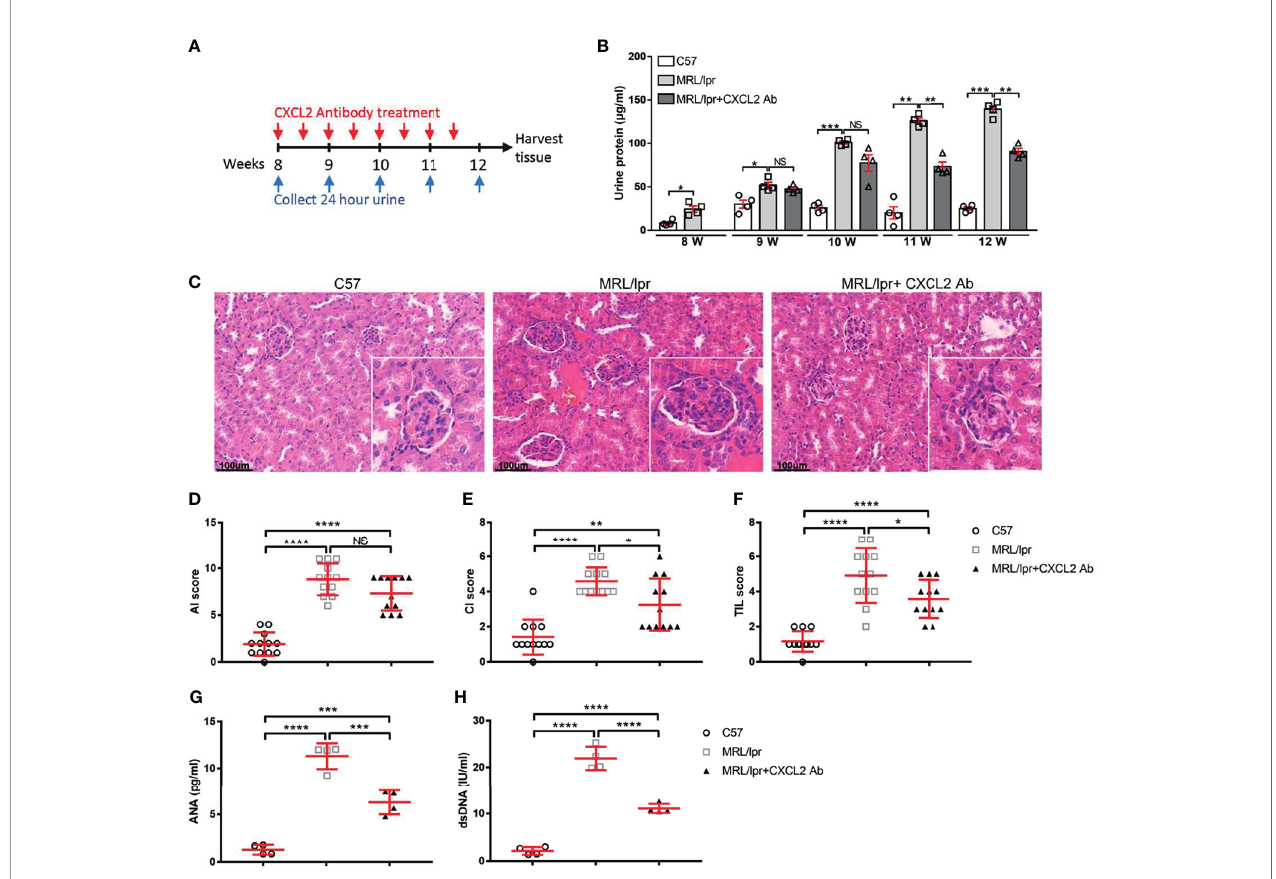
FIGURE 5 | Blocking of CXCL2 alleviates kidney damage in MRL/lpr mice. (A) Treatment schema: red arrows indicate days of CXCL2 neutralizing antibody treatment, and the blue arrows indicate time points for detection of 24 urinary proteins. (B) Urine of mice from different groups was collected at the indicated time points for the proteinuria assay. *** P < 0.001; ** P < 0.01; * P < 0.05; NS, not signi fi cant. (C) Representative images of H&E straining of kidney sections obtained from mice from different groups. Inserts, details of a typical glomerulus. (D – F) Lesion scores of the activity index (D) , chronicity index (E) , and tubulointerstitial lesions (F) of mice in different groups. Data are shown as the mean ± SEM (n = 4 animals/group, 3 sections/animal). **** P < 0.0001; *** P < 0.001; * P < 0.05. (G, H) Immunological markers of SLE in the serum of mice from different groups. The antinuclear antibodies (ANA) were determined by immuno fl uorescence (G) , anti-dsDNA levels were measured by ELISA (H) . **** P < 0.0001; *** P < 0.001; ** P <